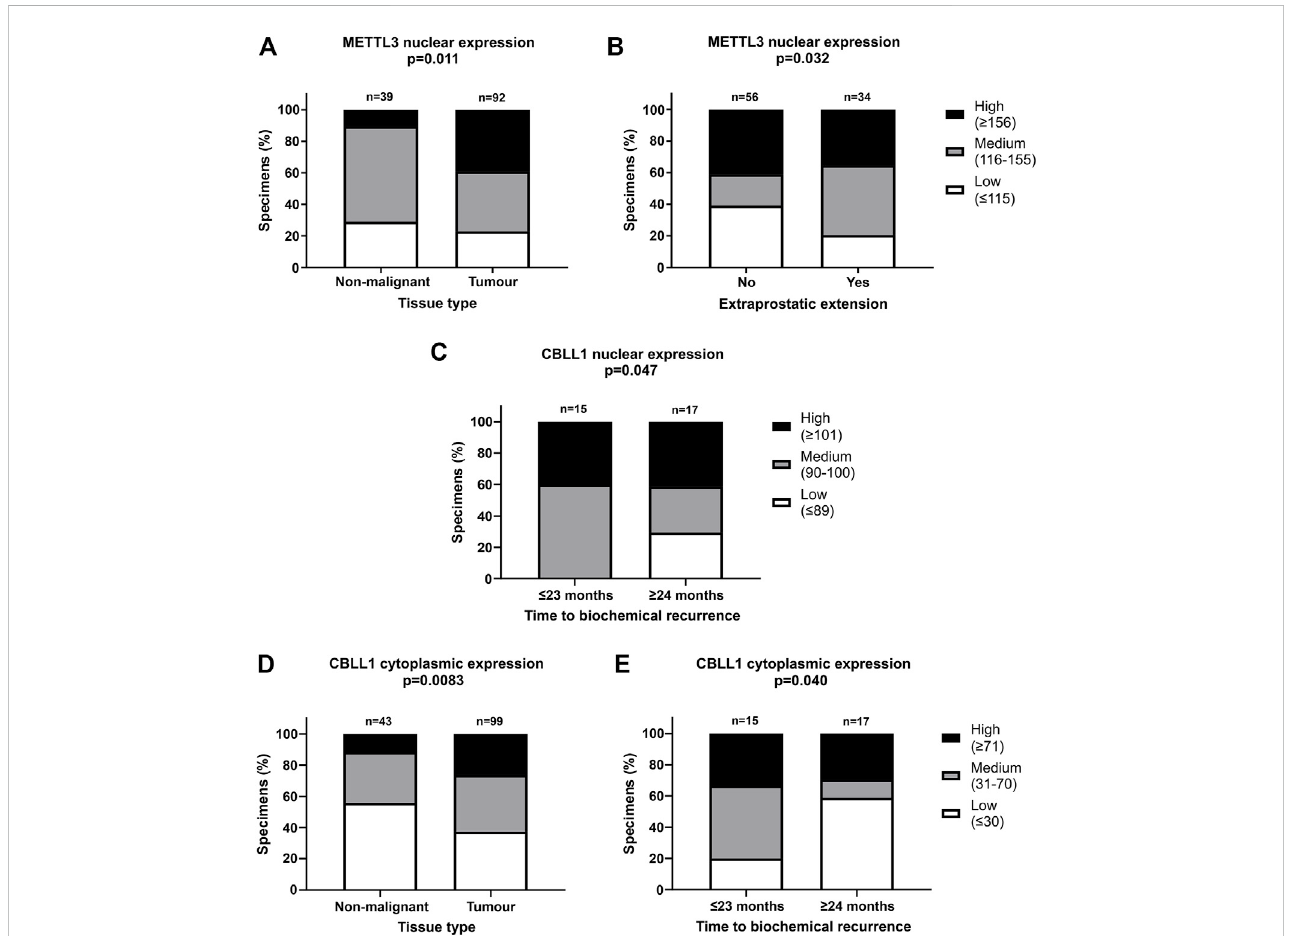
FIGURE 3 Signi fi cant correlations of clinicopathological parameters with METTL3 and CBLL1 expression in prostate cancer TMA. IHC staining of 159 patient samples was assessed by H-score, divided into high, medium, and low expression groups and correlated with prostate tissue type (A,D) , extraprostatic extension (B) and biochemical recurrence of PCa (C,E) . In METTL3 nuclear, low: ≤ 115, medium: 116 – 155, high: ≥ 156; in CBLL1 nuclear, low: ≤ 89, medium: 90 – 100, high: ≥ 101; in CBLL1 cytoplasmic, low: ≤ 30, medium: 31 – 70, high: ≥ 71. Analysed by χ 2